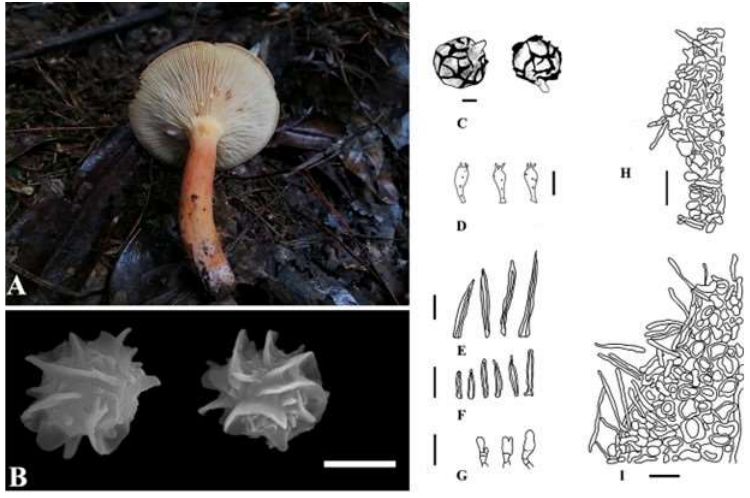
Figure 4. Lactifluus jianbaensis microscopic characteristics: ( A ) Fresh basidiomata (holotype). ( B ) SEM microphotographs. ( C ) Basidiospores. ( D ) Basidia. ( E ) Pleurocystidia. ( F ) Cheilocystidia. ( G ) Marginal cells. ( H ) Stipitipellis. ( I ) Pileipellis. Scale bars: 4 µm ( B ), 3 µm ( C ), and 30 µm ( D – I ). Pilei a re 42.81–46.25 mm diameter, and are slightly concave in the center to convex to planoconvex with a broadly depressed center, dark orange (W3C) in the center, mango orange (#FF8040) on the edge, and velvet in the center when young, gradually becoming applanate to infundibuliform or concave. The surface is dry and smooth. The edge bends flat and is brittle in consistency. Lamellae are decurrent, white (W3C) to cream (#FFFFCC), thick and brittle, and dense, and the edge is concolorous to marginate. The attachment to the stipe varies from adnate to adnate with a decurrent tooth to decurrent, and the milk is colorless to white (#FEFCFF) and turns brown in a few minutes after being bruised. The